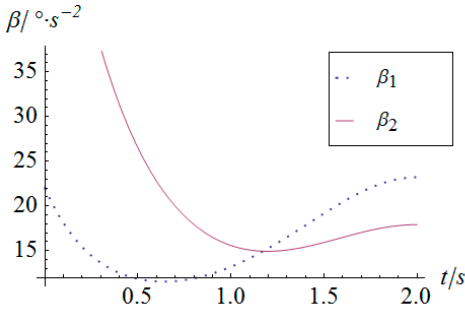
Sensors 2016 , 16 , 1485 11 of 15 Figure 9. Angular acceleration vs. time of the actuators. Figure 9. Angular acceleration vs. time of the actuators. Figure 9. Angular acceleration vs. time of the actuators. Figure 9. Angular acceleration vs. time of the actuators.